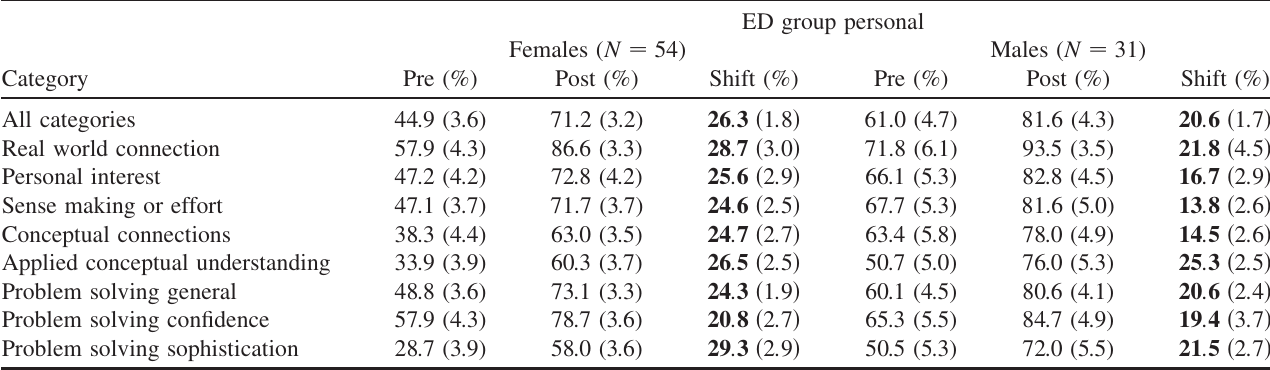
TABLE VII. Relationships between all categories and gender for ED group in pre-CLASS and post-CLASS test [standard error in parentheses; large shifts ( p < 0 : 05 ) in bold font].